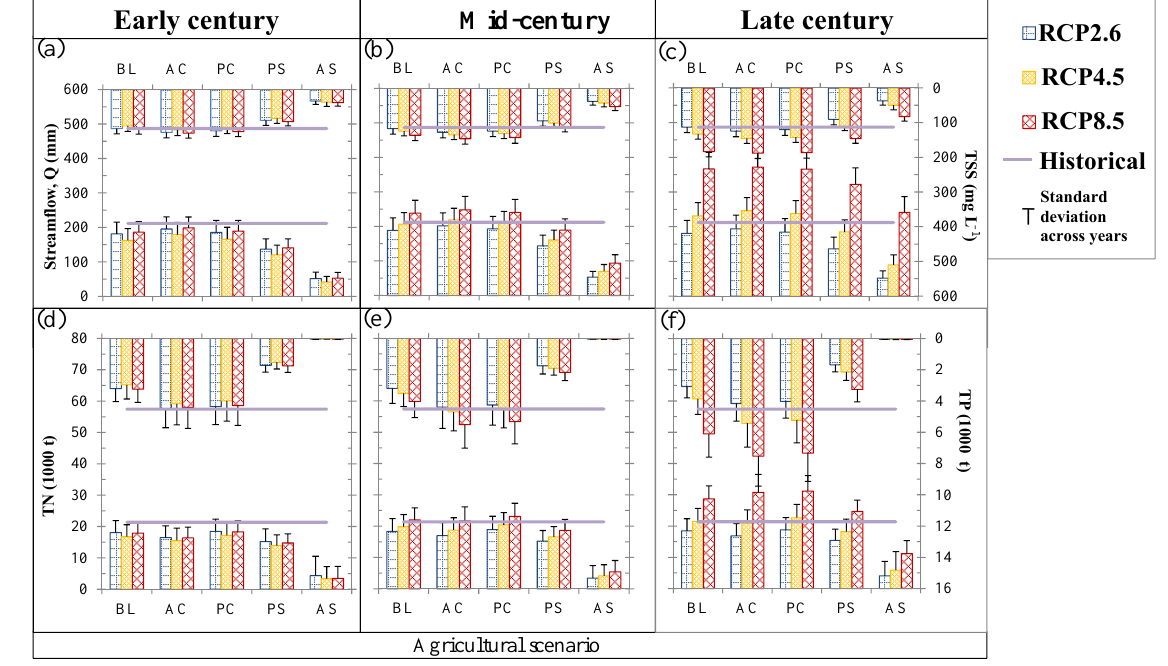
Figure 4. Streamflow ( Q ), total suspended solid (TSS), total nitrogen (TN) and total phosphorous (TP) results at the outlet of the watershed in different agricultural and climate